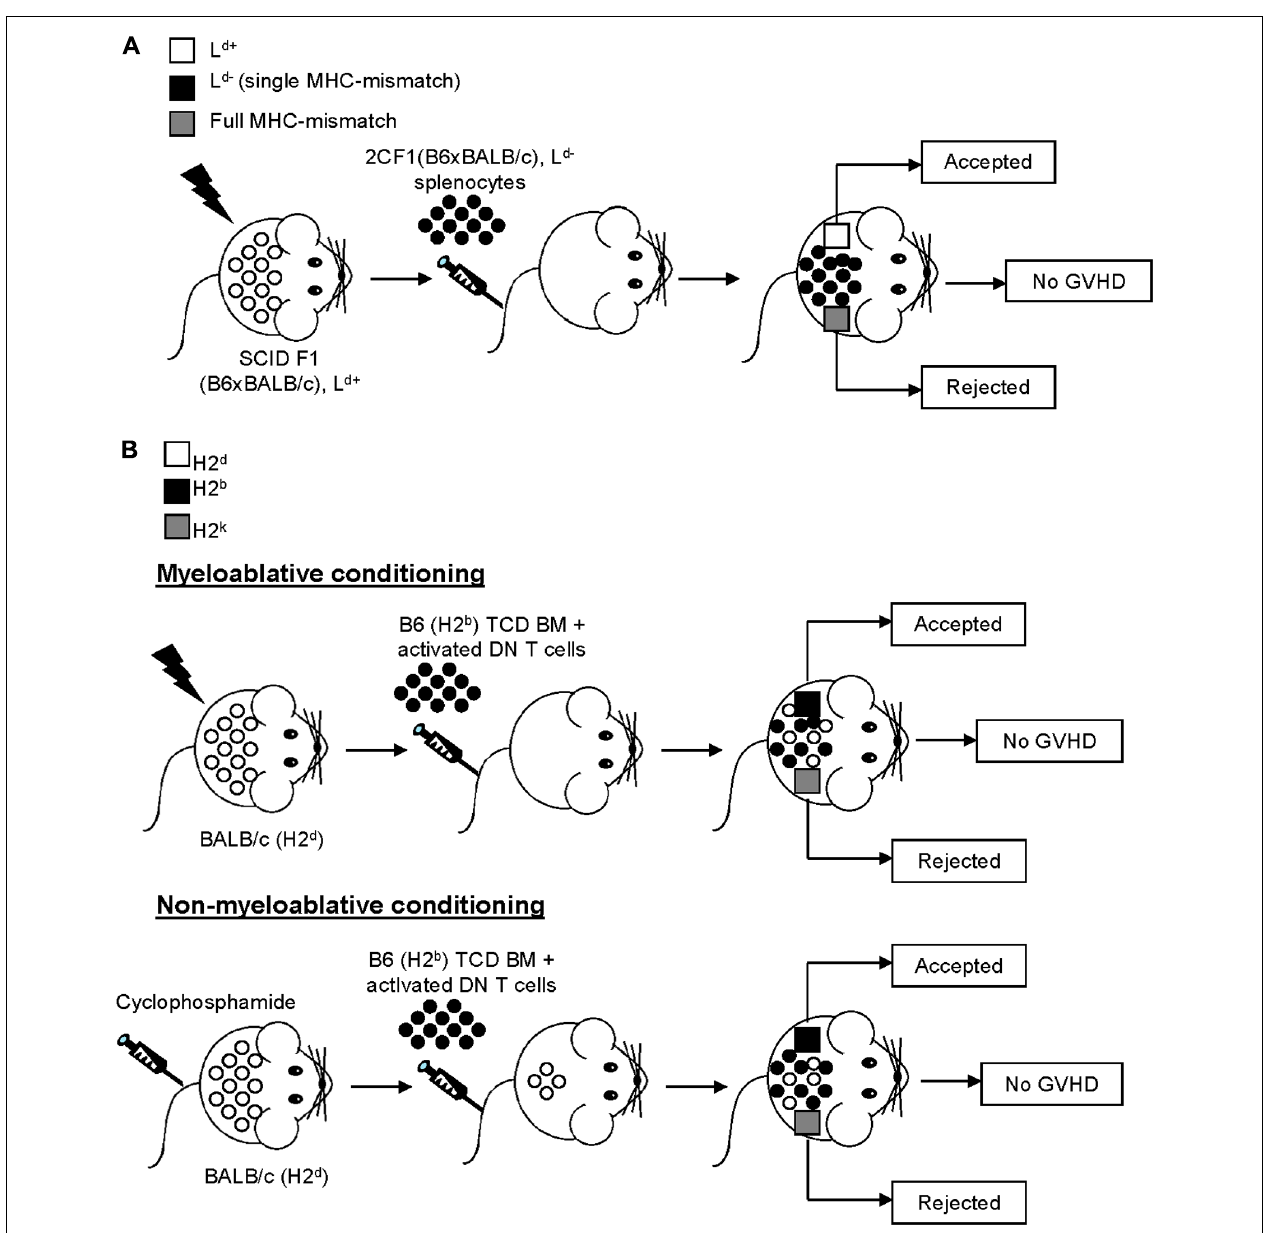
FIGURE 2 | Double negativeT cells promote tolerance while inhibiting GVHD. (A) Immunodeficient SCID F1 mice (H2 b,d , L d + ) were sublethally irradiated and reconstituted with 2CF1 (H2 b,dm2 , L d − ) L d -specific spleen cells.Three weeks later, recipient mice were given skin grafts from F1 (L d + , in white) and full MHC-mismatch, third party (in gray) mice.The third party skin graft was rejected, whereas the skin graft from the F1 (L d + )